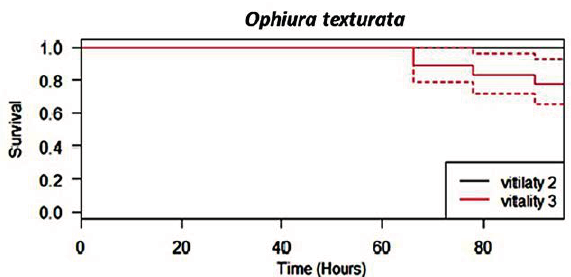
Fig. 4. – K-M model to assess the survival of Ophuira texturata at vitality levels 2 and 3.